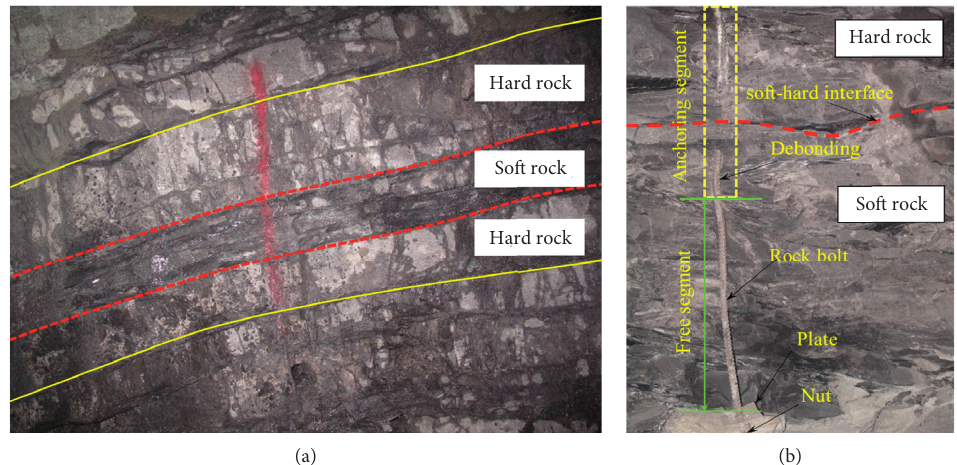
Figure 1: (a) Typical soft and hard composite rock strata in underground engineering and (b) an exposed rock bolt in situ.